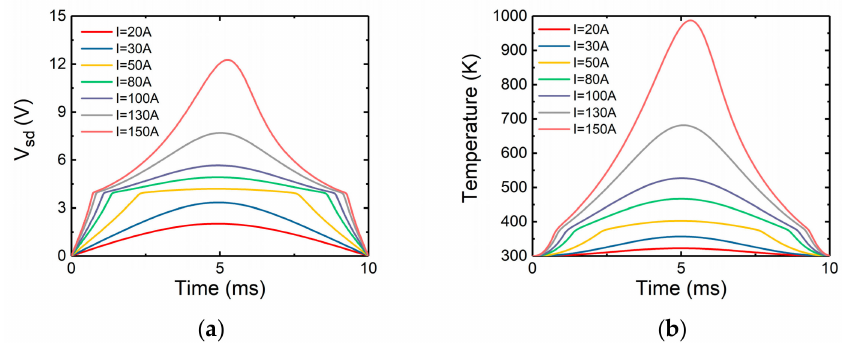
Figure 16. When the channel is conducting, the simulated variation of ( a ) source-drain voltage, ( b ) maximum temperature versus